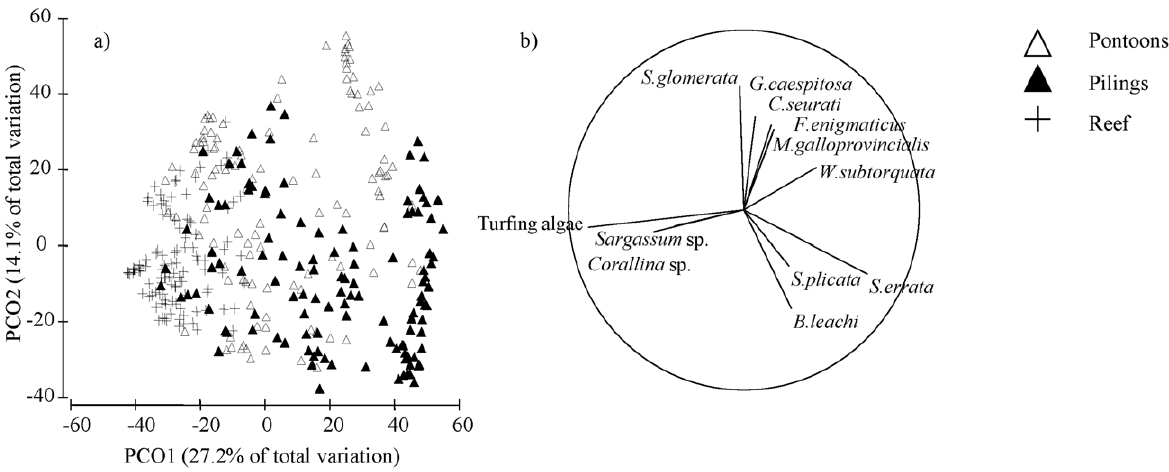
Figure 2. Principal co-ordinates analysis (PCO) comparing the hard-substrate community composition between artificial and natural habitats. Sampling was done on vertical surfaces of pilings, pontoons and rocky reefs at four sites in 2006 and 2007. The PCO plot (a) is coded by habitat and the vector overlay (b) indicates which taxa were positively correlated ( . 0.4) with the axes. The length of the vector indicates the strength of the relationship.